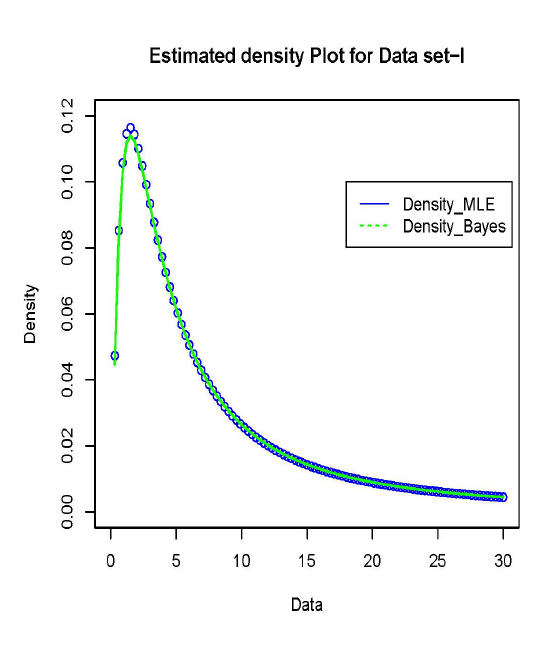
Figure 2 – Estimated density function plot for the data set-I.